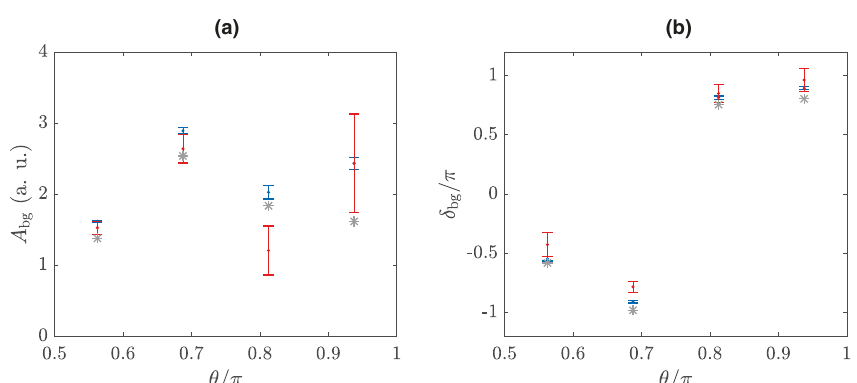
Fig. 3 Extracted phase and amplitude values for background contribution. A comparison of the fi t parameters (cid:2) a amplitude ð A bg Þ and b phase ð δ bg Þ (cid:2) as determined from fi tting the experimental (red) and theoretical (blue) data to the model for different angular ranges (i) – (iv) shown in Fig. 1. The grey stars represent the corresponding values calculated by quantum scattering calculations. The error bars correspond to fi tting with 95% con fi dence. The x -axis represents the mean value of θ in different angular sectors labelled as (i) – (iv) in